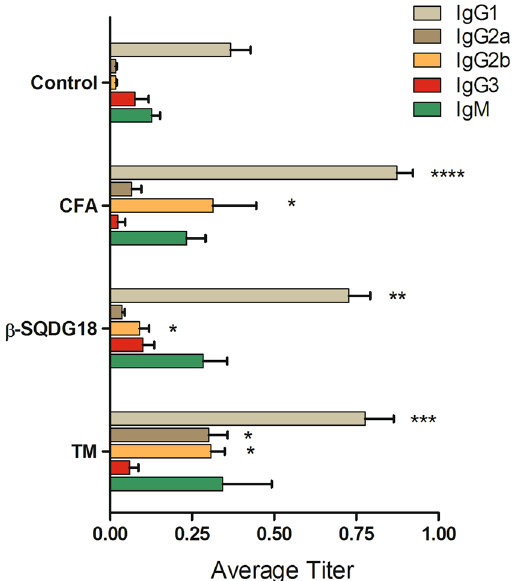
Figure 3. Humoral response of mice after immunization to ovalbumin formulated with β -SQDG18. C56 BL/6 mice were divided into 4 groups and inoculated twice with 5 µ g antigen (OVA) in presence or absence (Control) of 2.5 mg β -SQDG18 (1:500 w/w). Co-administrations of OVA together with Complete Freund’s Adjuvant (FCA) or TiterMax (TM) were used as positive controls. Serum anti-OVA antibodies were measured by ELISA and results are shown as endpoint titer (mean/standard error). No increase in OVA-specific IgA was observed. Asterisks indicate significant differences from the control group at a 95% (P < 0.05) confidence level, as determined using two-way ANOVA